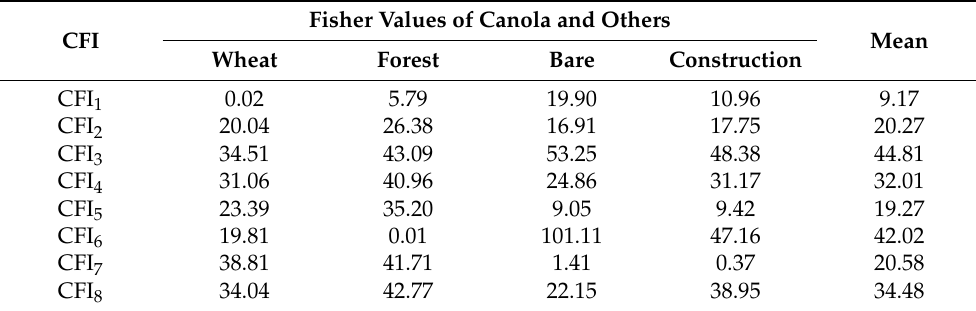
Table 2. Fisher values of canola and other ground objects for various CFIs. Fisher Values of Canola and Others CFI Wheat Forest Bare